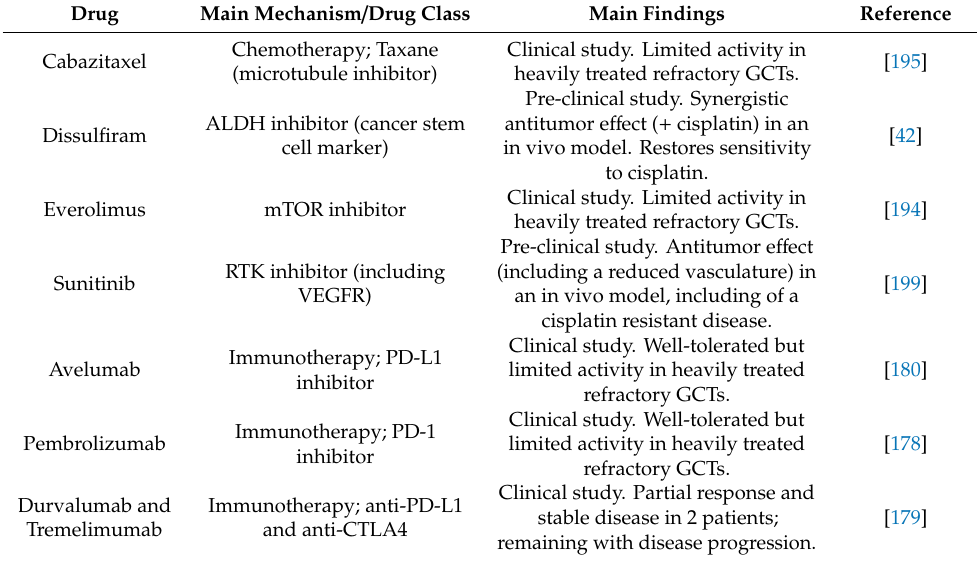
Table 2. Summary of some recent studies exploring novel treatment options for cisplatin-resistant testicular germ cell